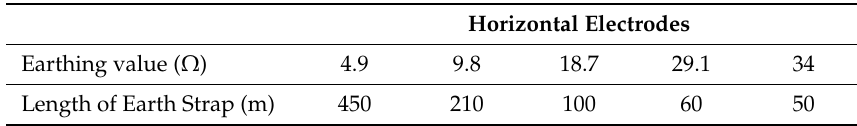
Table 2. Horizontal electrode.